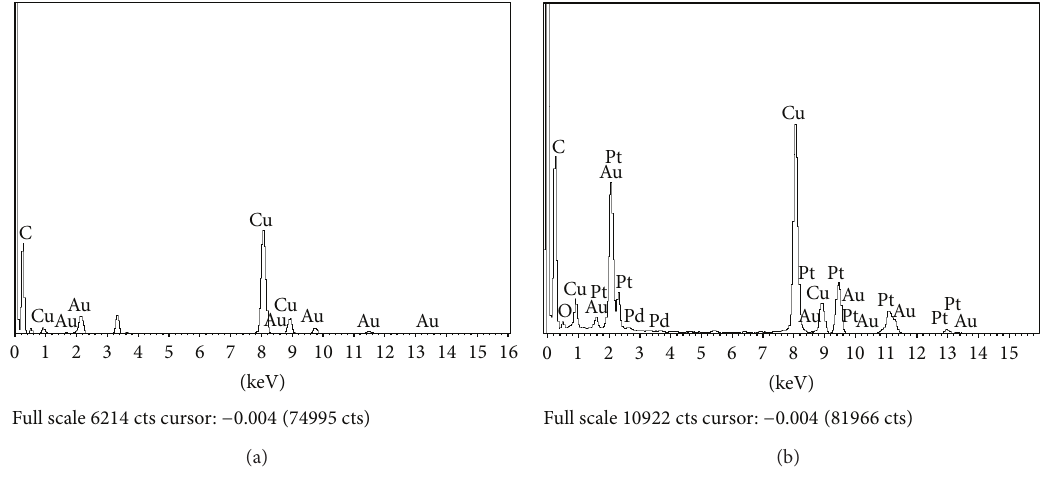
Figure 6: The selected EDS spectra of (a) Au-CNT and (b) Pt and Pd loaded